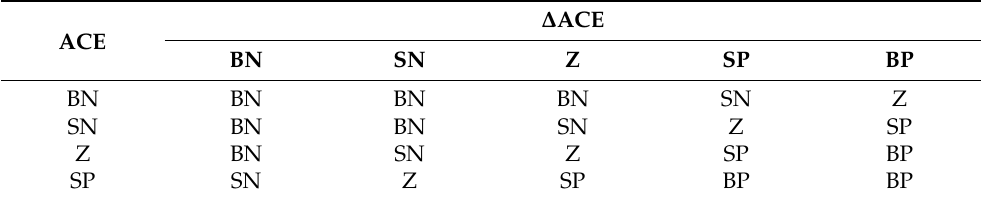
Figure 3. MFs implemented for the FLC.